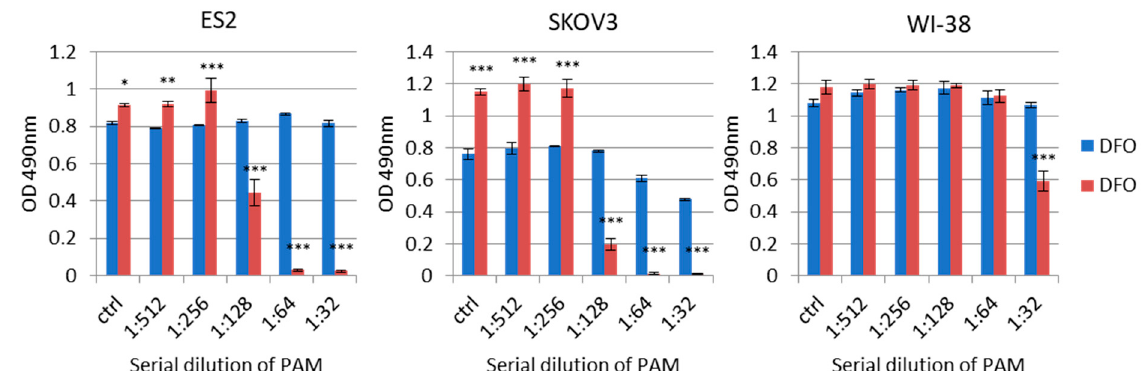
Figure 2. The influence of intracellular iron on the antitumor effect of PAM in cancer cells and normal cells. PAM was prepared with the same conditions as those used in the animal model. Cells were pre-treated with 200 µ M DFO (Desferal for injection 500 mg, Novartis Pharma, Tokyo, Japan) before PAM treatment. ES2 and WL-38 cells were seeded at a density of 1 × 10 4 cells, and SKOV3 cells were seeded at a density of 3 × 10 3 cells in the wells of 96-well plates. Cell viability was assayed by a 3-(4,5-dimethylthiazol-2-yl)-5-(3-carboxymethoxyphenyl)-2-(4-sulfophenyl)-2H-tetrazolium, inner salt (MTS) assay at the corresponding PAM dilution ratio. Data are the mean ± SD. Three independent experiments were performed. The two-way ANOVA with Tukey’s post hoc test for equal variances was carried out between DFO-treated and -untreated cells. Statistics are shown as *** p < 0.001; ** p < 0.01; * p < 0.05.